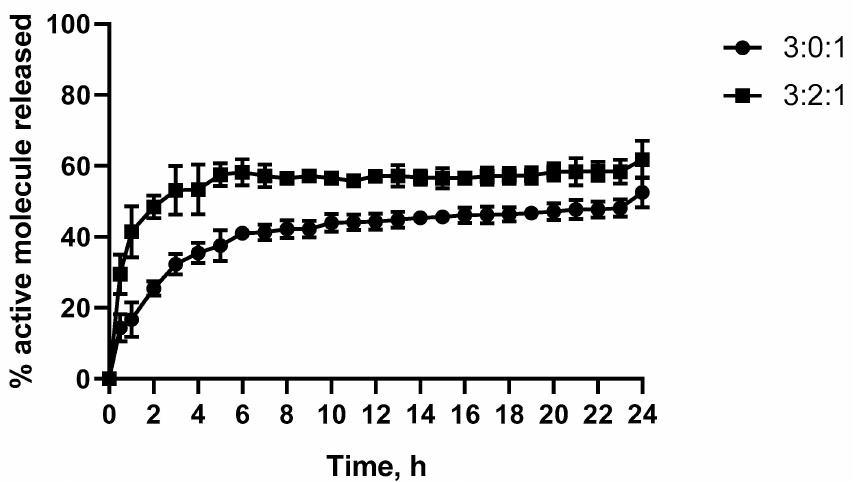
Figure 5. Kinetic release of CN (expressed in %) under flowing conditions in a USP apparatus four dissolution tester (PBS, pH 7.4 at 37 ◦